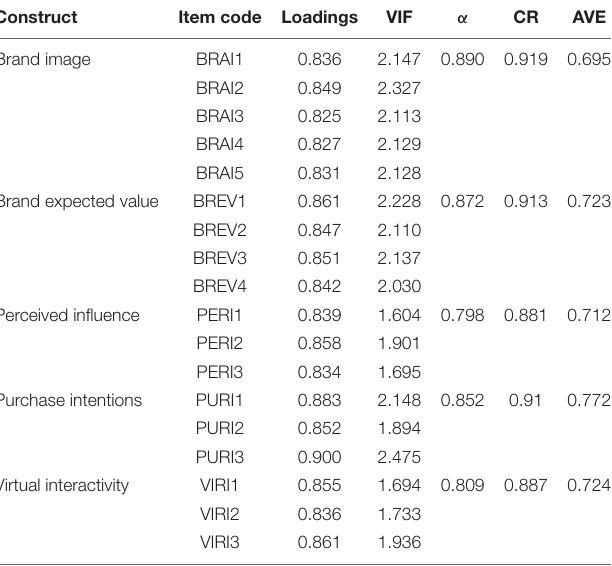
TABLE 2 | Measurement model assessment: VIF, reliability, and convergent validity. Construct